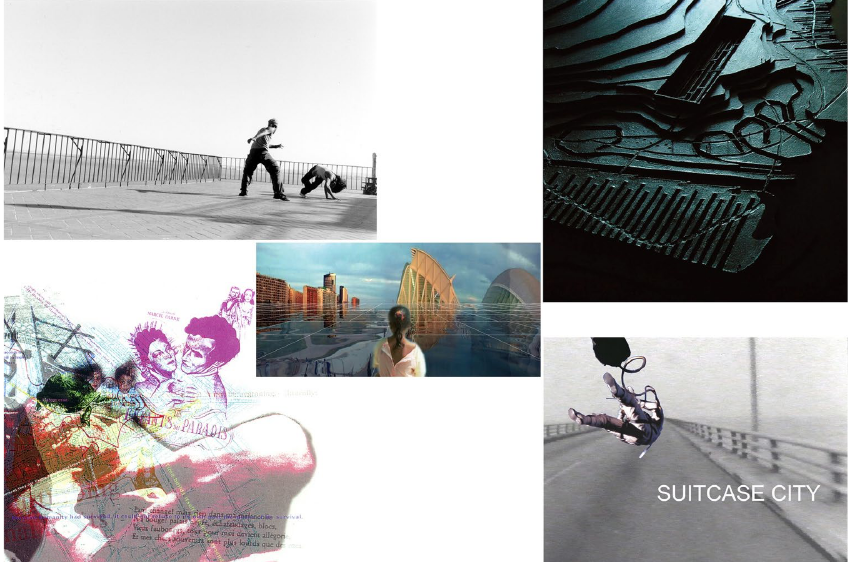
Figure 13 Student’s works from the AA Diploma Unit 3 by Julian Löffler, Jean Tark Park, Clara Kraft, Stephan Doesinger and Takanao Todo. (Clockwise from right to